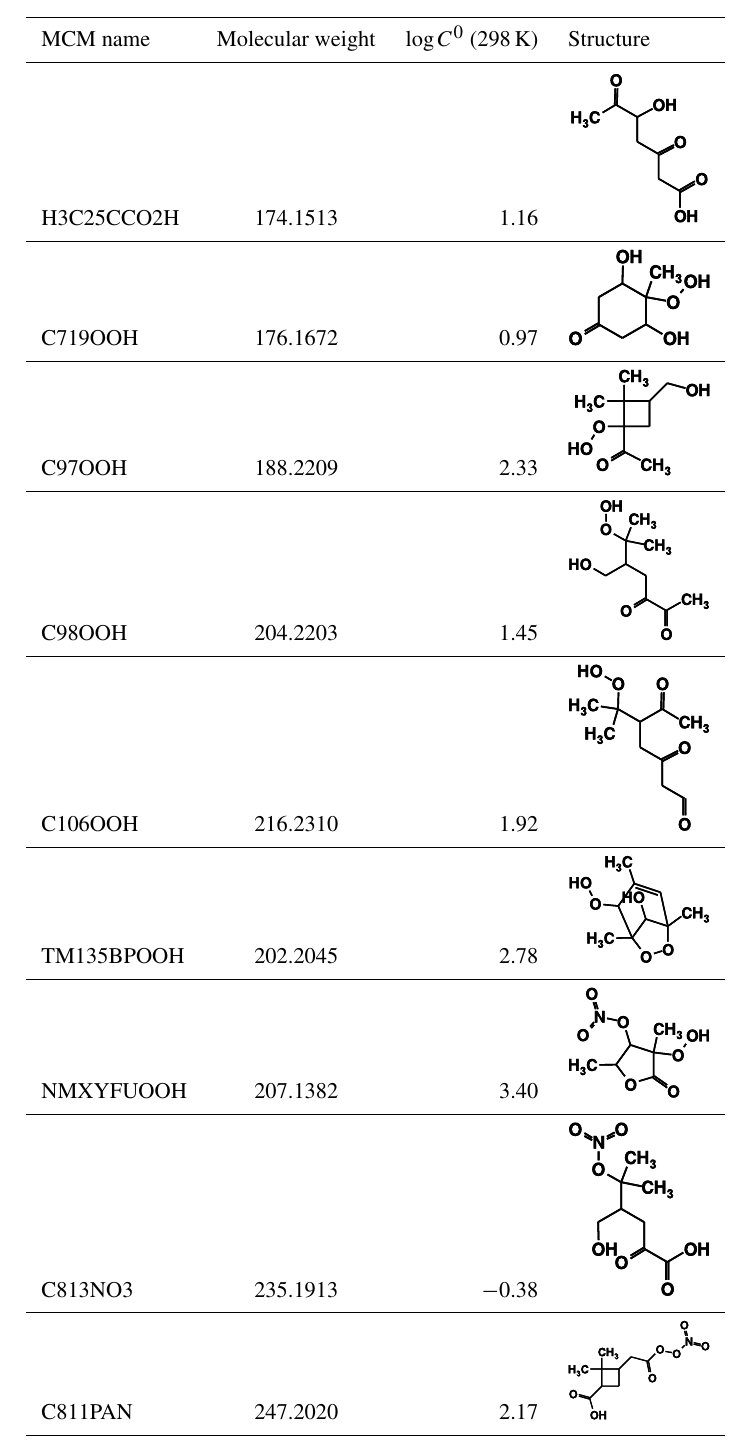
Table 2. Illustration of several polyfunctional molecules discussed in Section 3.